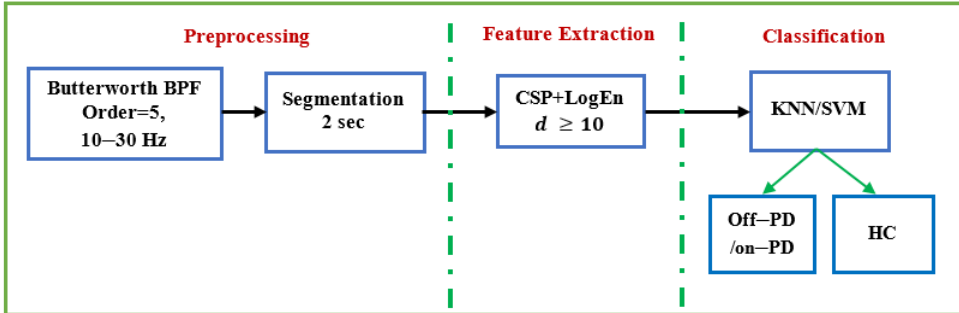
Figure 12. The complete method that provides the best performance.